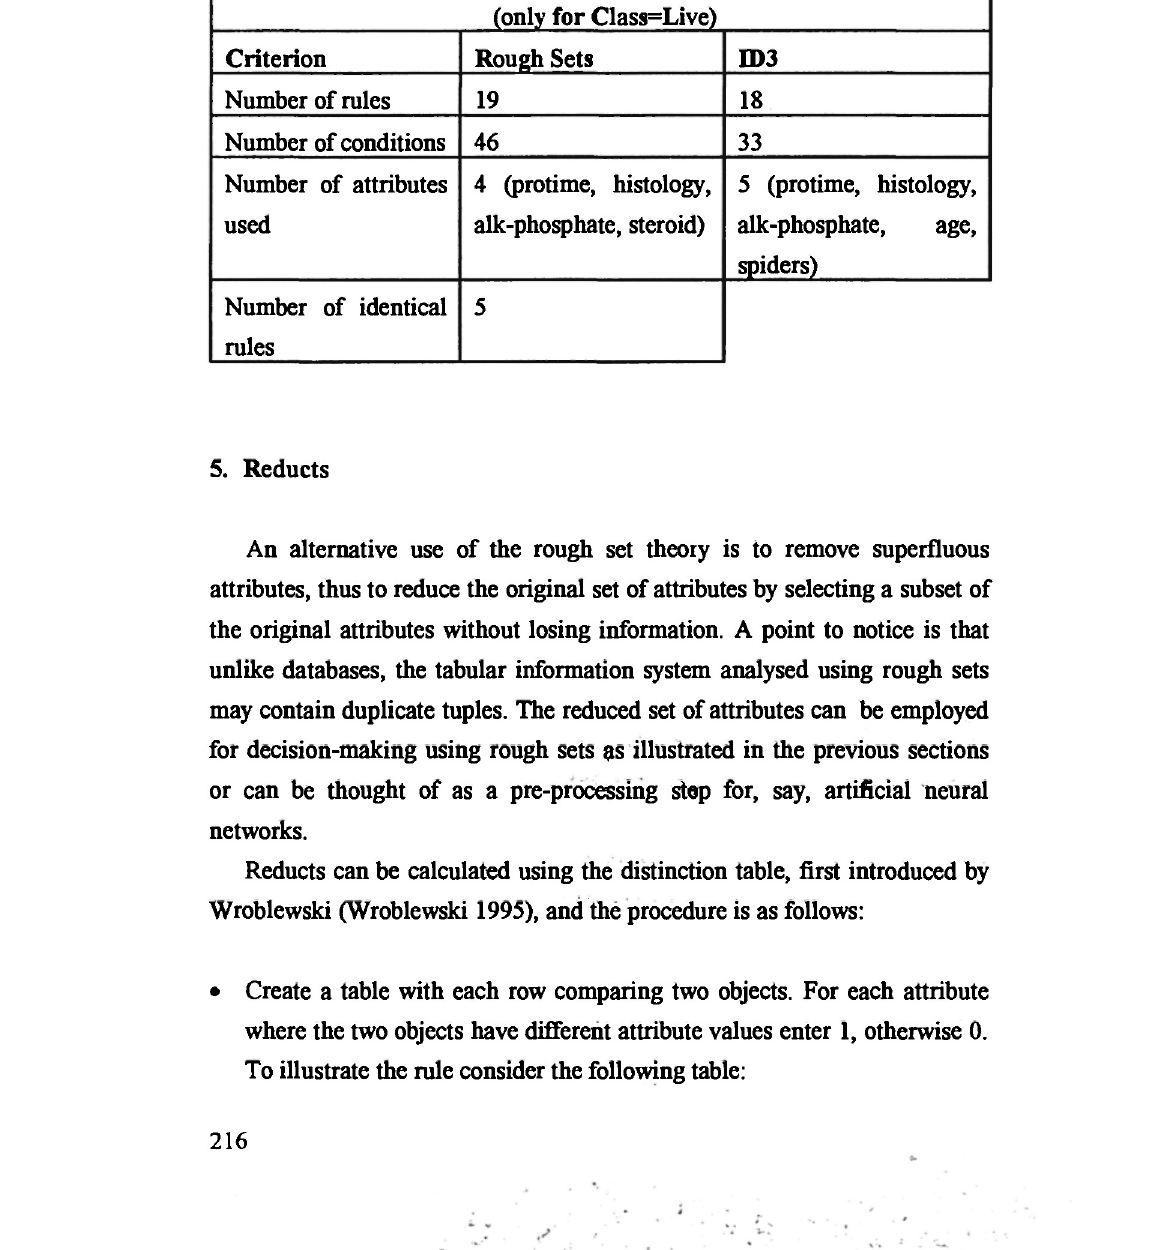
Table 7. A brief comparison of rough sets and